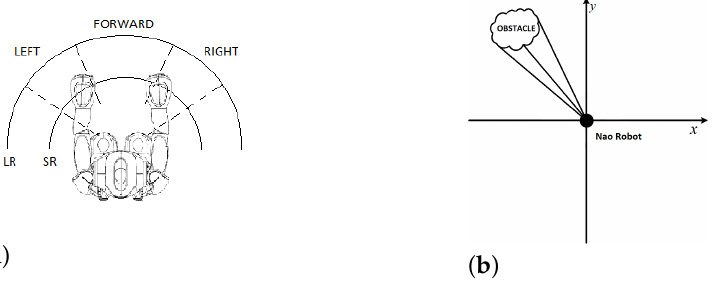
Figure 5. In ( a ), we see LiDAR detecting an obstacle. In ( b ), collected data are categorized based on the measurement